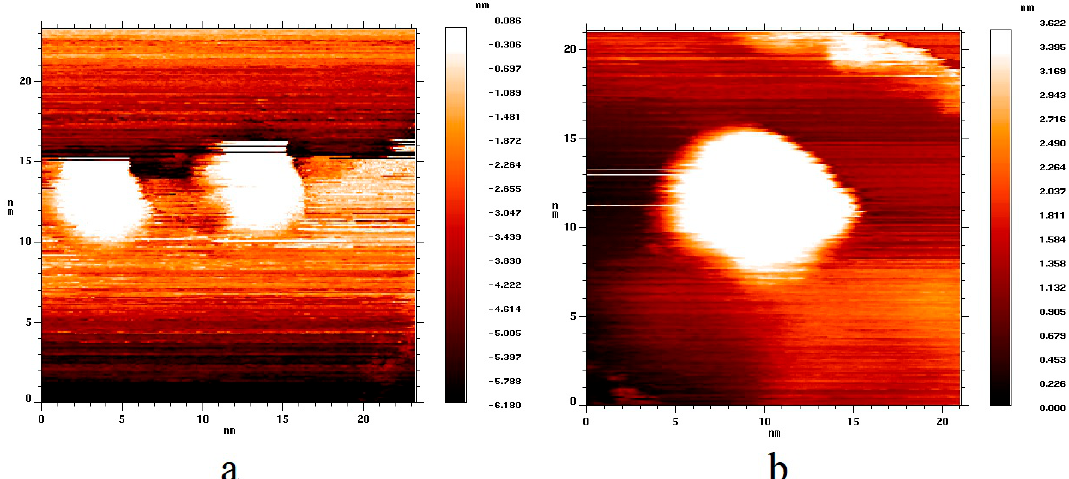
Figure 1. Topography images of the highly oriented pyrolytic graphite (HOPG) surface with deposited gold nanoparticles. ( a ) Sample with 5 nm nanoparticles (U bias = 2.0 V, I tunnel = 2.9 nA); ( b ) sample with 10 nm nanoparticles (U bias = 2.1 V, I tunnel = 3.1 nA).